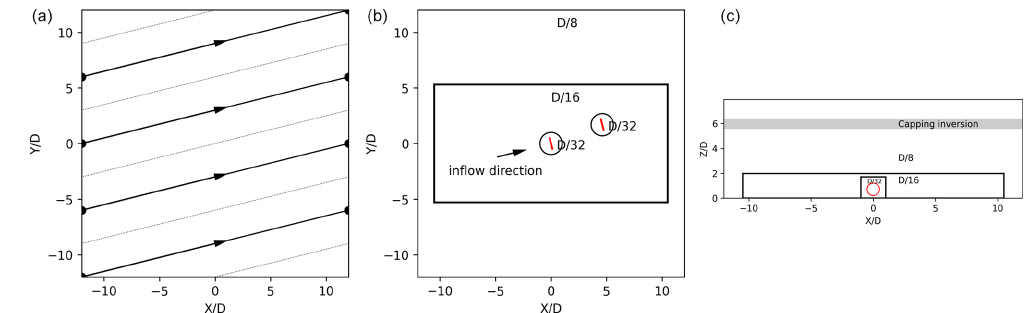
Figure 3. Domain size and mesh refinement zones for the ABL inflow case: (a) total distance traveled by the coherent structure before entering again into the domain in the same position and mesh refinement zones in a (b) horizontal and (c) vertical plane.